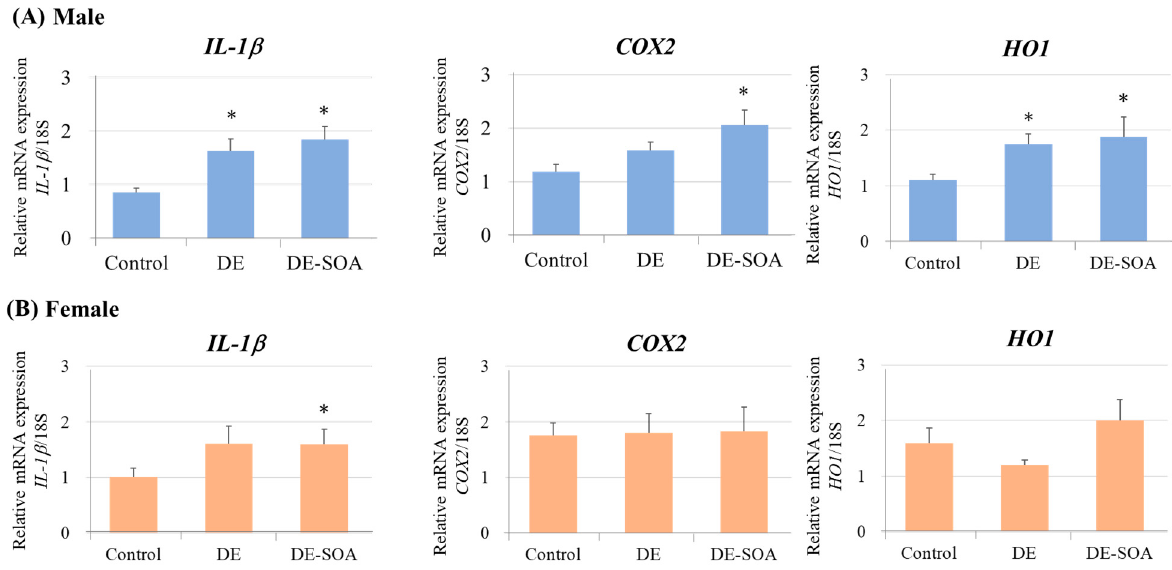
Figure 8. Messenger RNA expression levels of inflammatory and oxidative stress markers in the hippocampus. IL-1 β , COX2 and HO1 mRNAs in the hippocampus of 10-week-old ( A ) male and ( B ) female rats of the control and the DE- or DE-SOA-exposed groups. ( n = 10, * p < 0.05 vs. control).